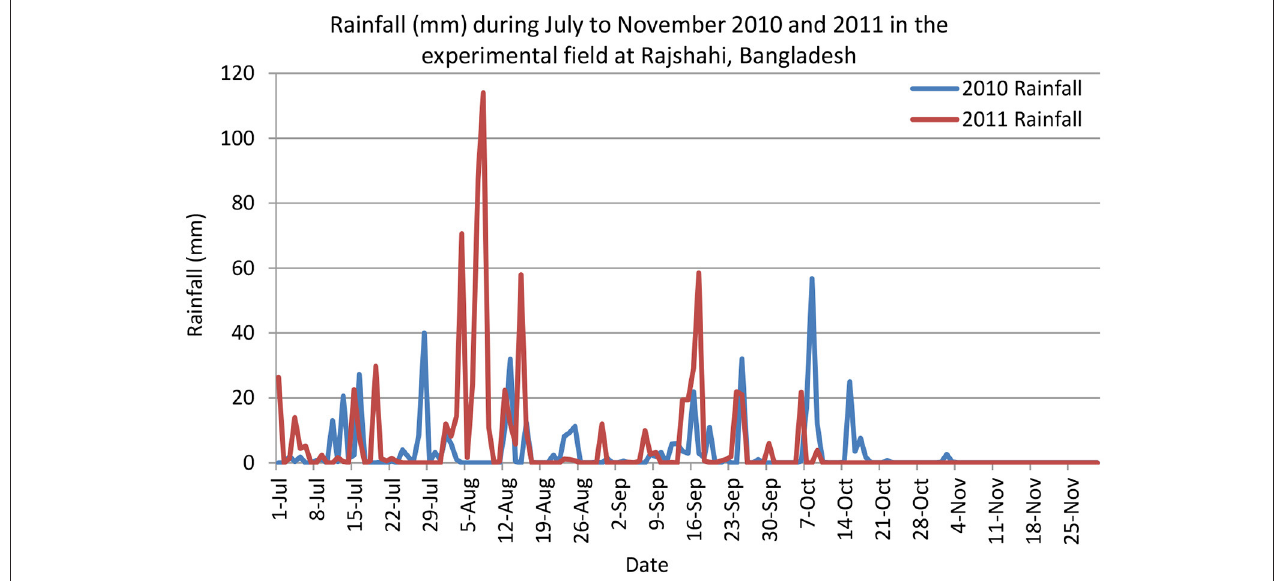
FIGURE 1 | Rainfall distribution in the experimental field of BRRI Rajshahi during July–November 2010 and 2011 (Data source: Weather station of BRRI Rajshahi, Bangladesh).